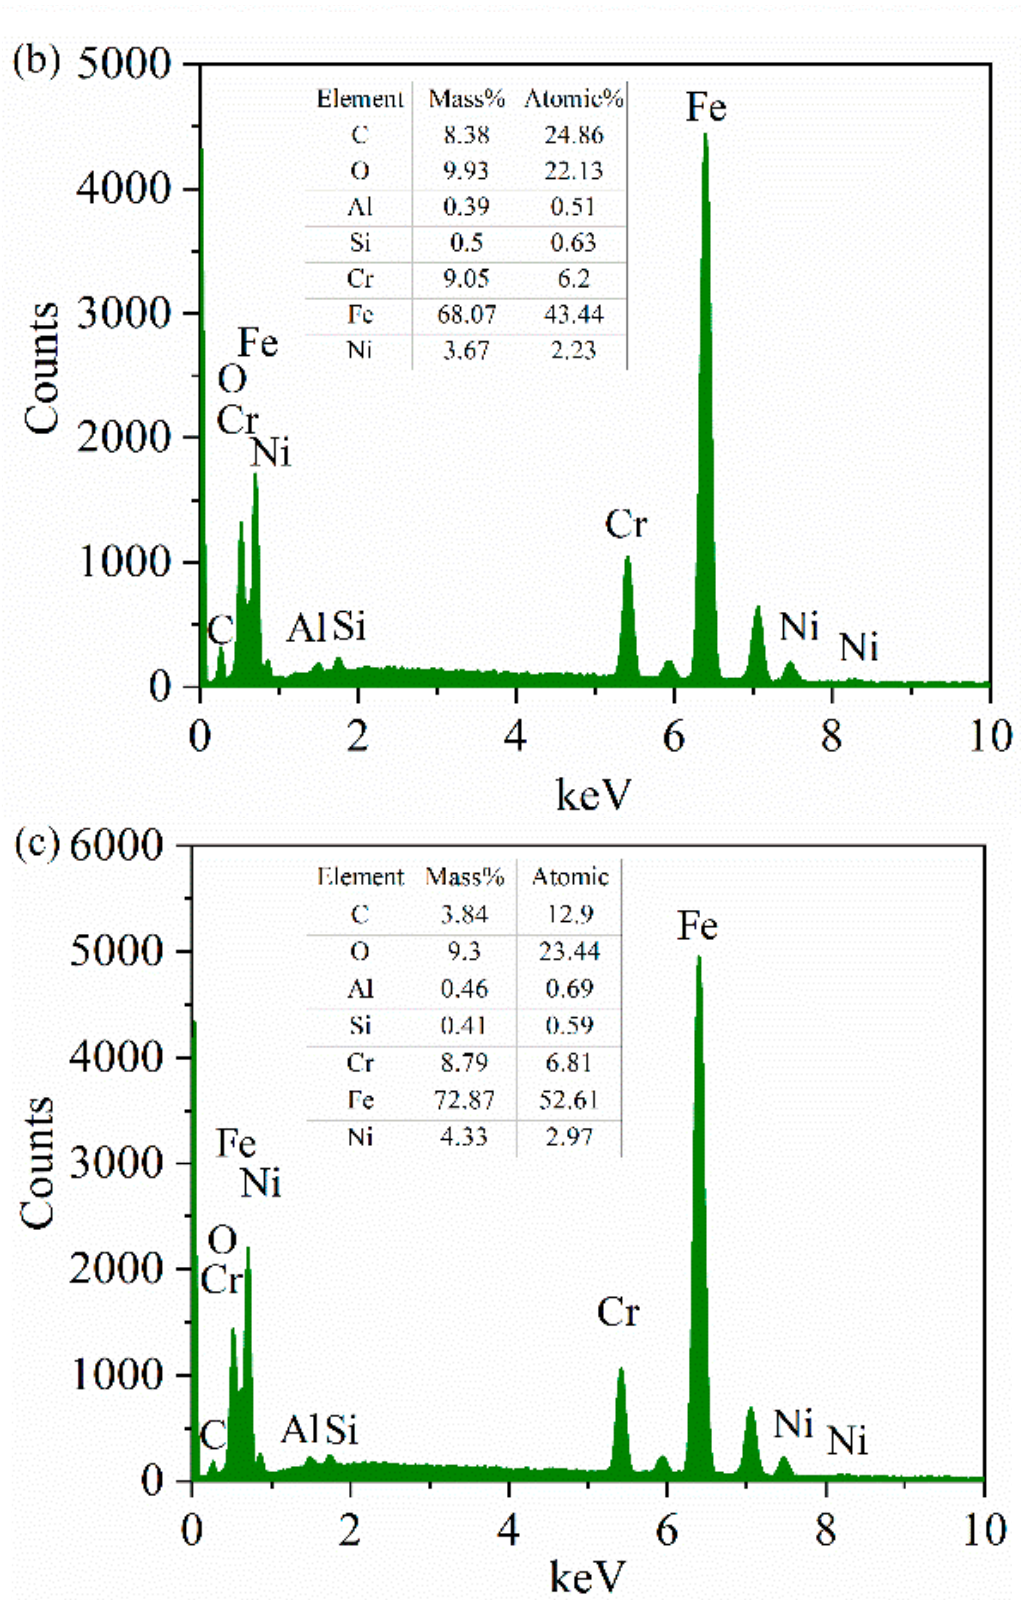
Figure 12. Comparison of EDS spectra of the picosecond textured worn balls: ( a ) rotation radius 15 mm; ( b ) rotation radius 18 mm; and ( c ) rotation radius 22.5 mm.